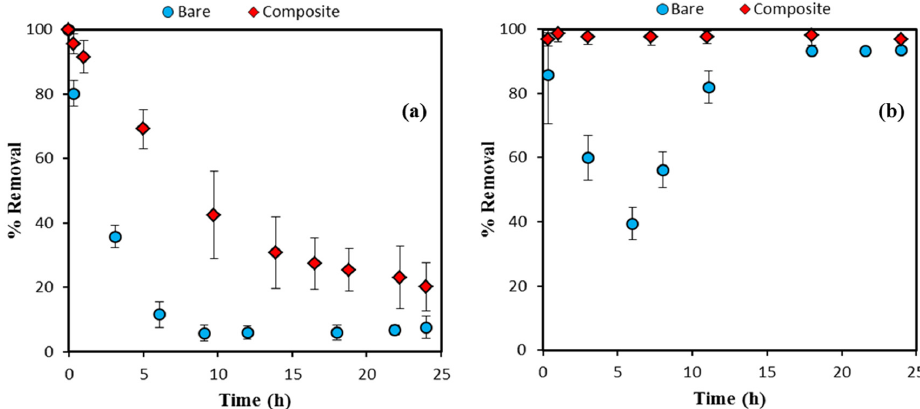
Figure 9. Organic dye removal efficiency of bare Al 2 O 3 membrane and POEM-directed TiO 2 /Al 2 O 3 composite membrane in the ( a ) absence and ( b ) presence of UV illumination .